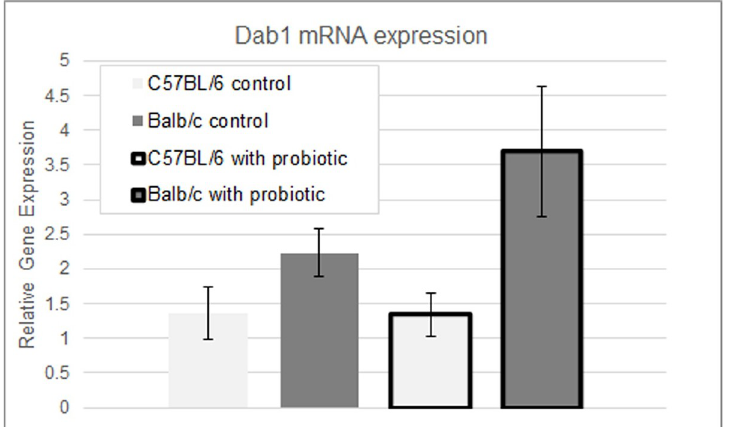
Fig 5. Dab1 mRNA levels in the brains of mice with and without B . longum treatment. Expression of Dab1 in the brains of Balb/c and C57BL/6 mice was measured using a qPCR. Values are relative to Rer1 control and error bars represent one standard deviation. The change in expression in Balb/c mice is statistically significant (p < 0.05). n = 4 per bar.